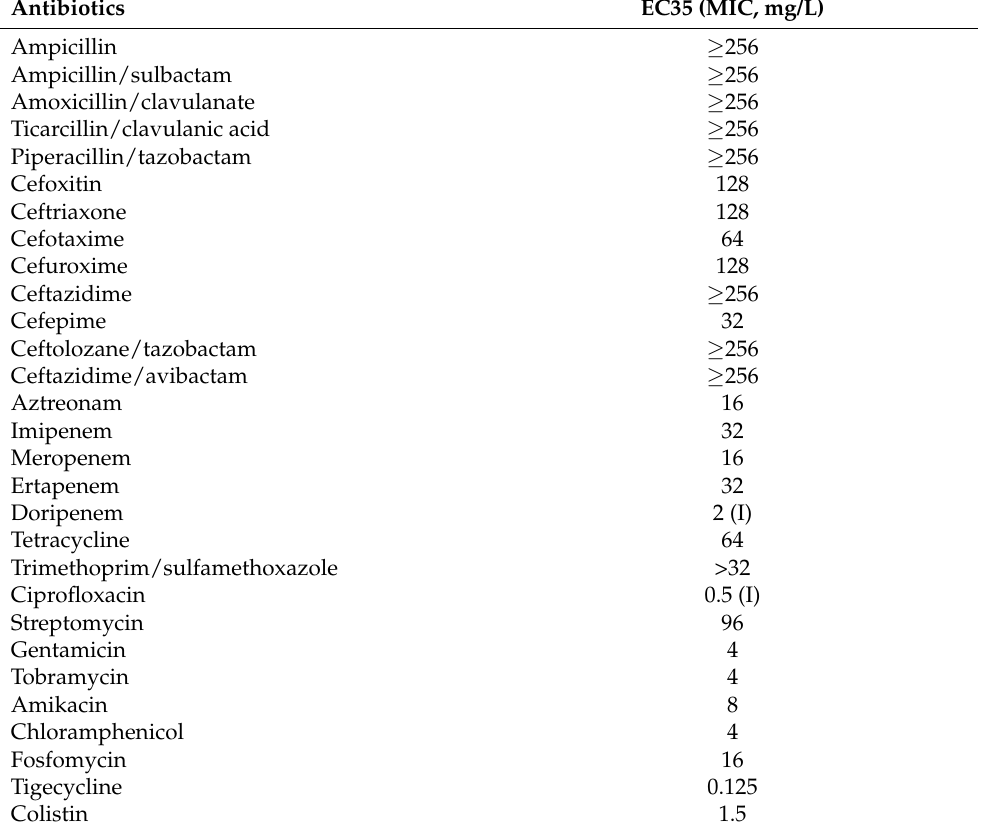
Table 1. EC35 antimicrobial resistance